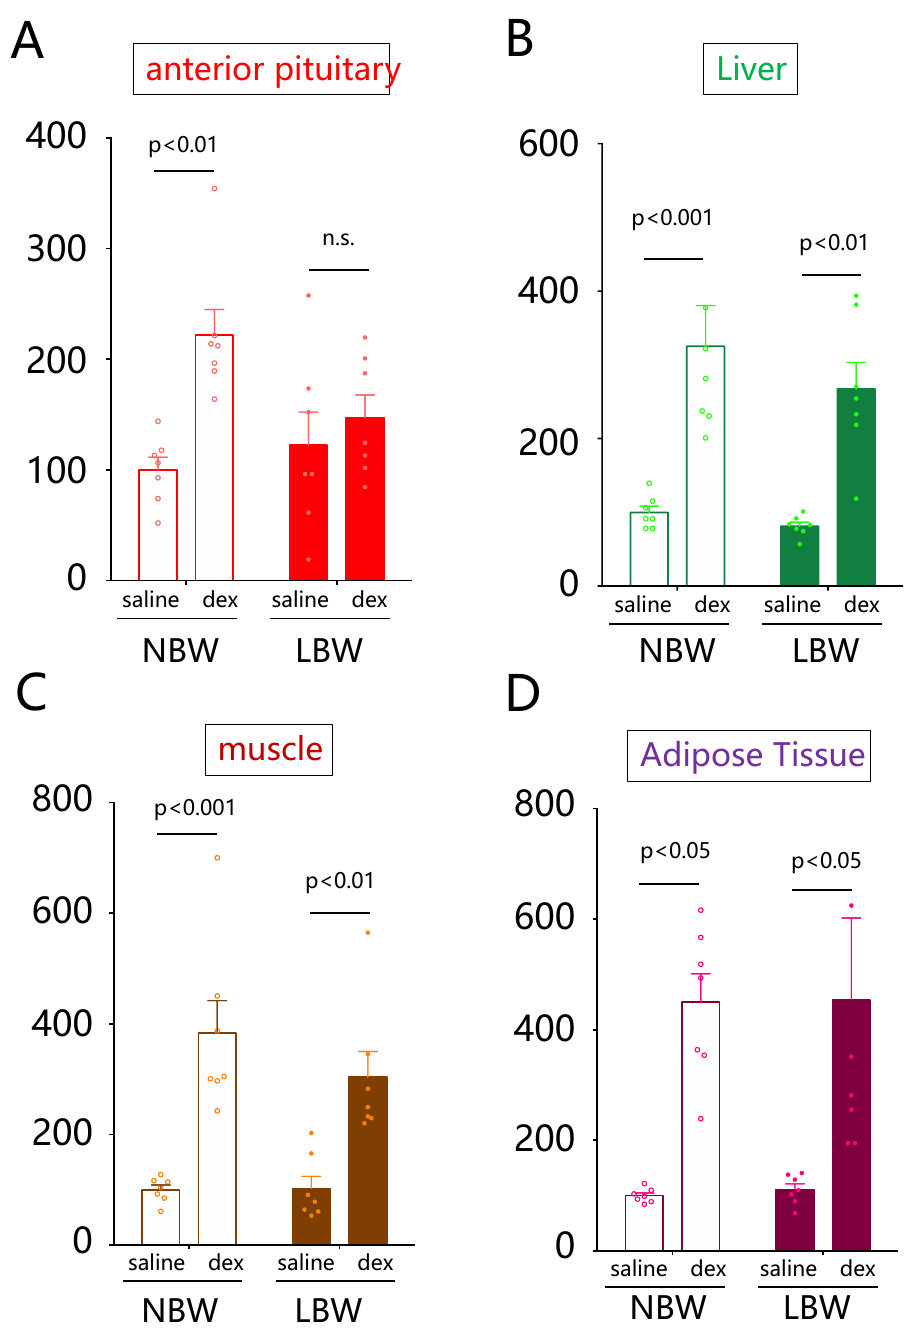
Figure 2. Changes in Fkbp5 mRNA expression after administration of dexamethasone (dex). Dex- amethasone (1 mg/kg bodyweight) or saline was injected intraperitoneally into male rats. The rats were killed 24 h after the injections. The mRNA expression levels of Fkbp5 in the pituitary ( A ), liver ( B ), skeletal muscle ( C ), and adipose tissues ( D ) of dexamethasone-administered control rats (NBW) and LBW rats were quantified. The mRNA expression level is a ratio obtained by correcting the ∆∆ CT values of Fkbp5 mRNA with the ∆∆ CT values of GAPDH and setting the value of NBW to 100 ( n = 6). Statistical analysis was performed using 2-way ANOVA followed by Tukey’s post hoc test for multiple comparisons. NBW, normal birthweight; and LBW, low birthweight, n.s.; not